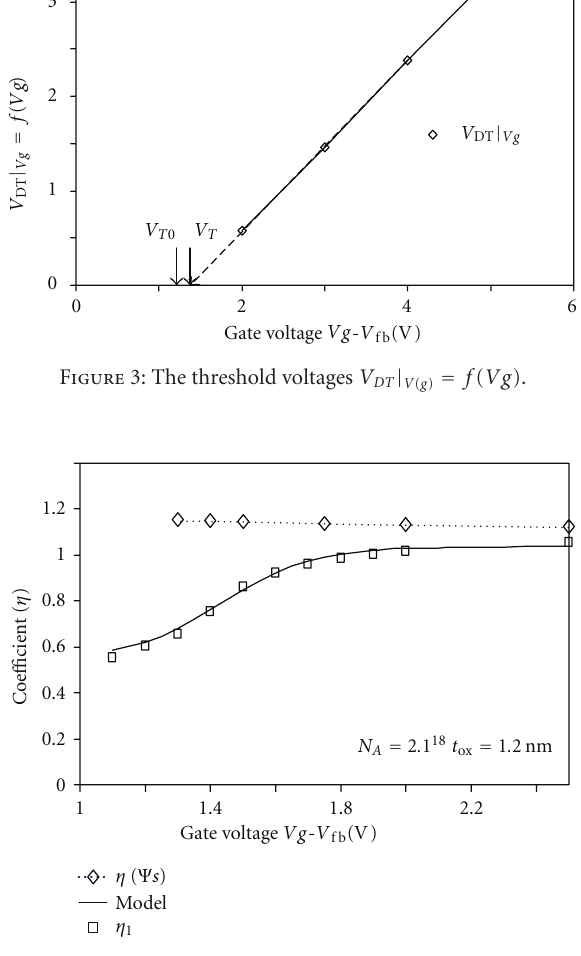
Figure 4: η ( Vg ) modeling by exponential functions. ( η 2 f = 1.08; N =